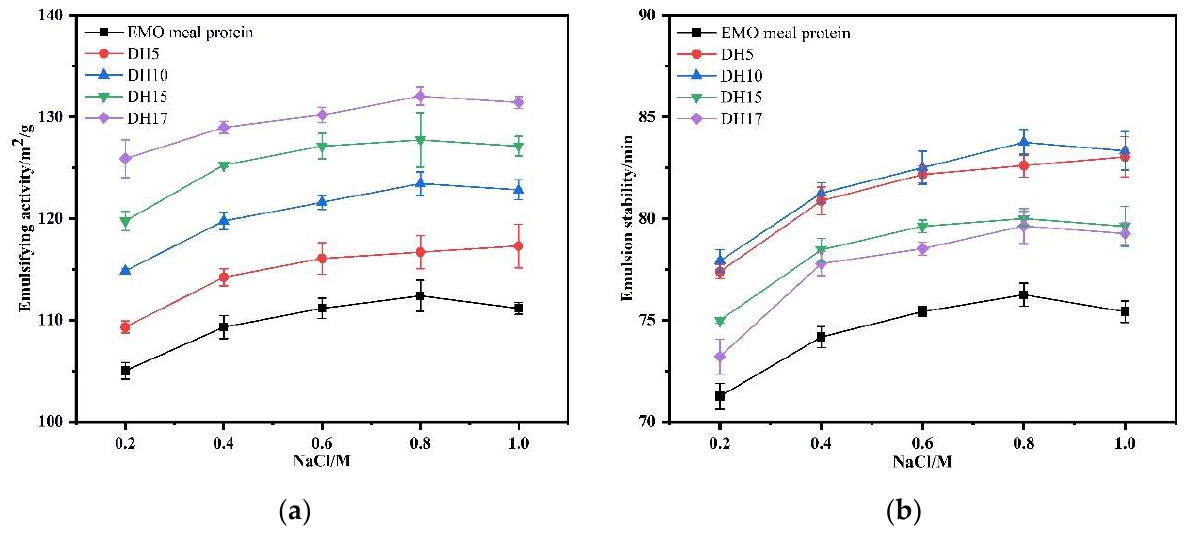
Figure 11. Effect of NaCl on emulsifying capacity ( a ) and emulsion stability ( b ) of the EMO meal protein and hydrolysates with different DH.